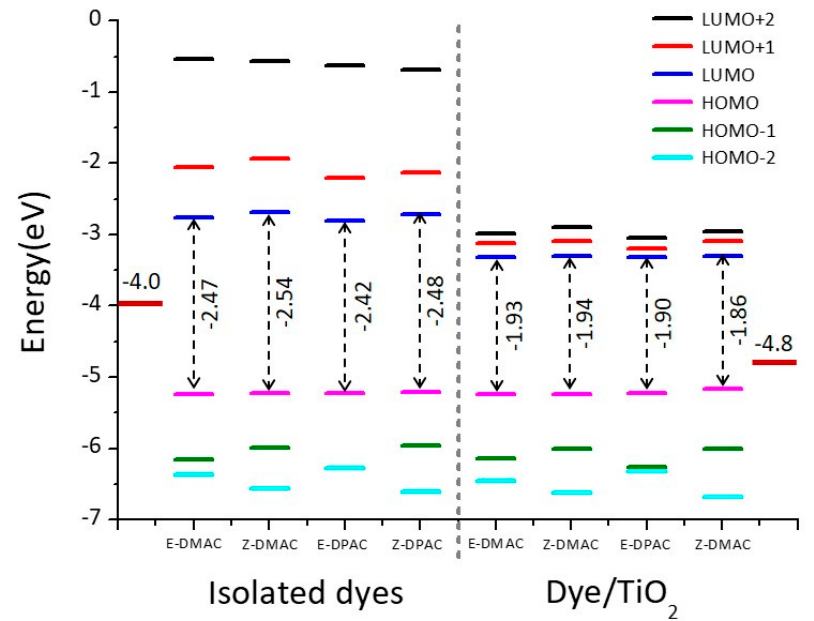
Figure 5. Molecular orbital energy diagrams of trans and cis isomers of DMAC and DPAC as isolated dyes and dye/TiO 2 complexes.